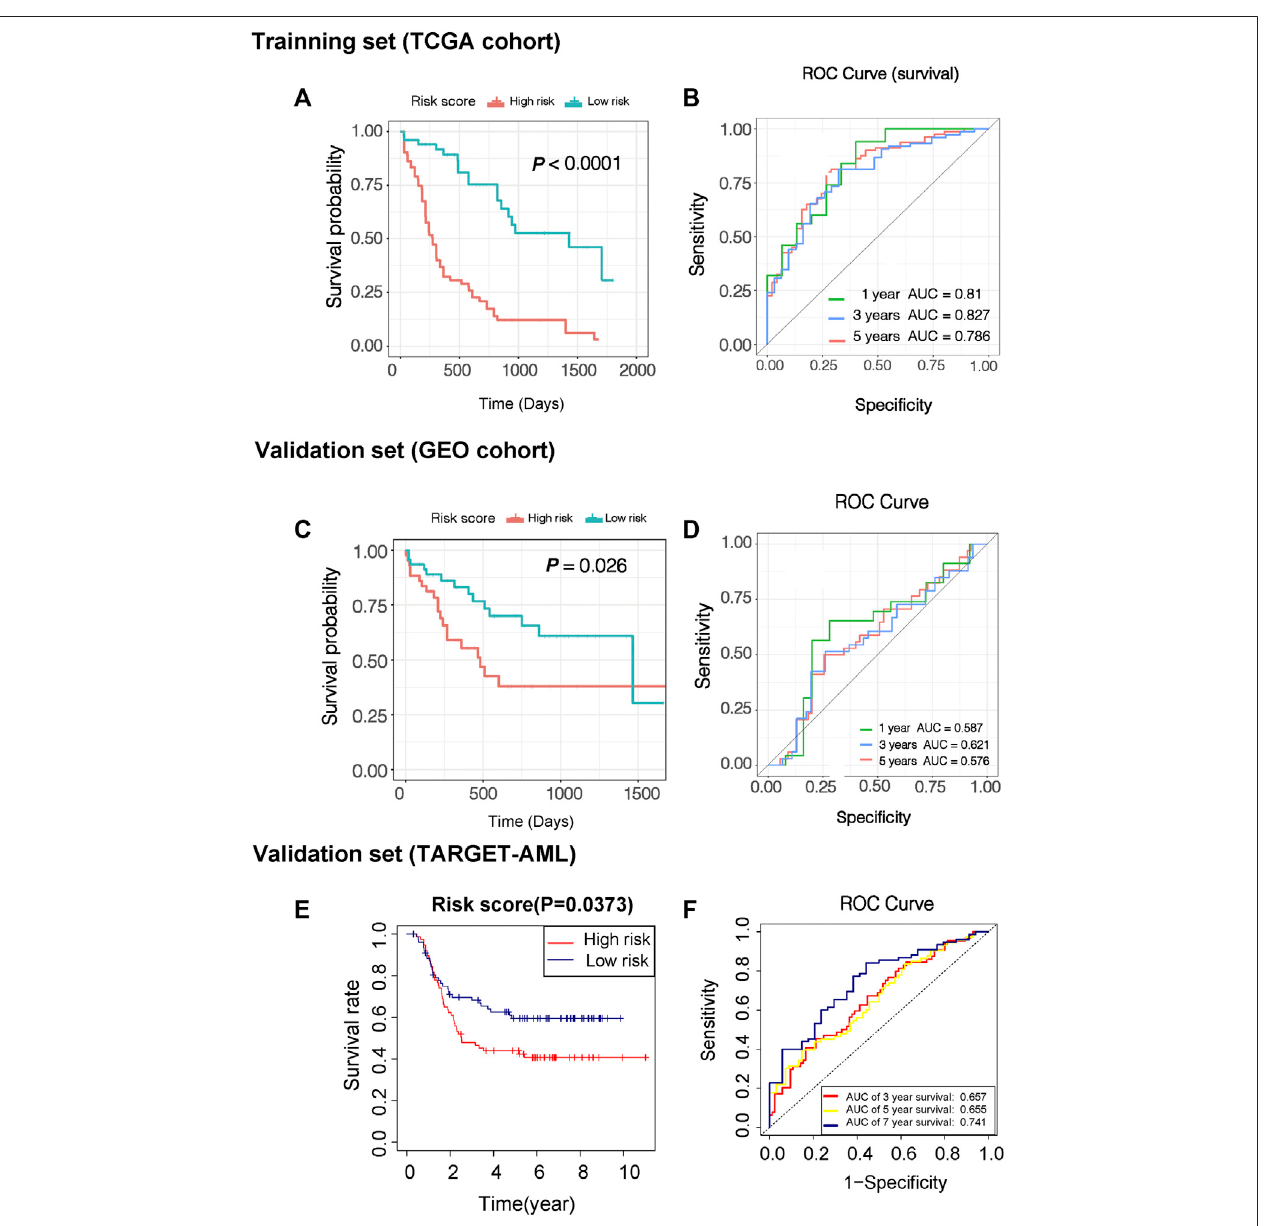
FIGURE 4 | Evaluation of predictive ef fi cacy of prognostic models. (A) KM survival curves of two risk score groups in the training set (TCGA-LAML data sets). (B) ROC curves in the training set (TCGA-LAML data sets), and the 3-year overall survival rates were 0.827. (C) KM survival curves of two risk score groups in the validation set (GSE71014). (D) ROCcurvesinthe validationset (GSE71014) and the 3-year overallsurvivalrates were0.621. (E) KM survivalcurvesoftworisk scoregroups in the validation set in another validation set (TARGET-AML). (F) ROC curves in another validation set (TARGET-AML) and the 7-year overall survival rates were 0.741.